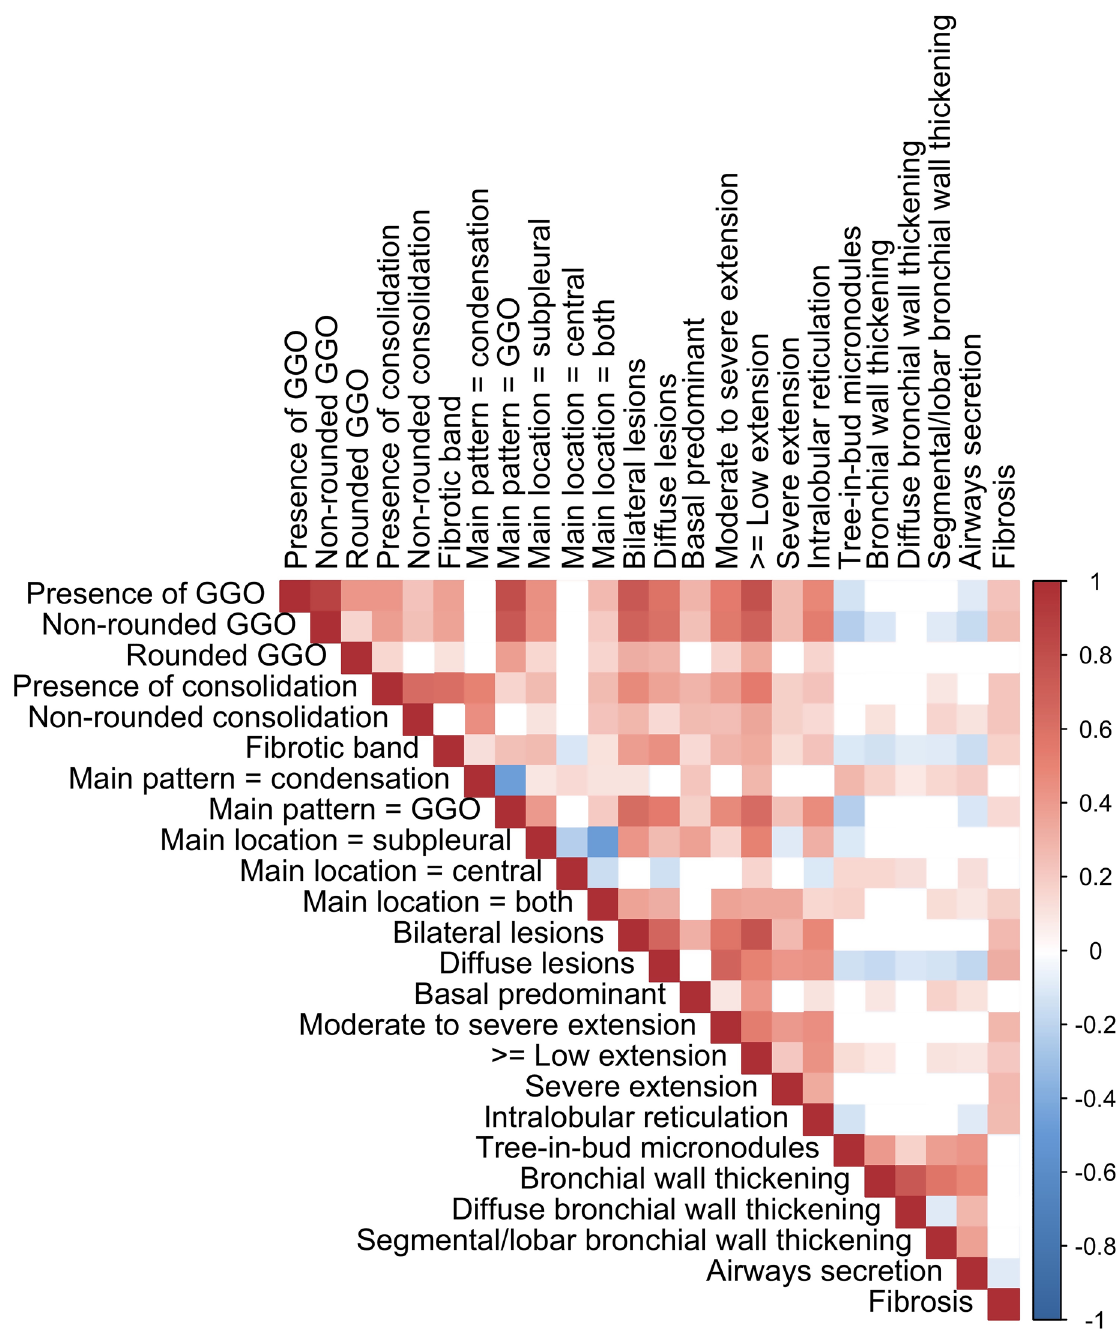
Figure 2. Correlation matrix of the 24 dichotomized radiological variables with a significant association with the RT-PCR status at univariate analysis. The colour-coding only corresponds to significant correlation (p < 0.05 according to Spearman test), from red (positive correlations) to blue (negative correlations). GGO ground-glass